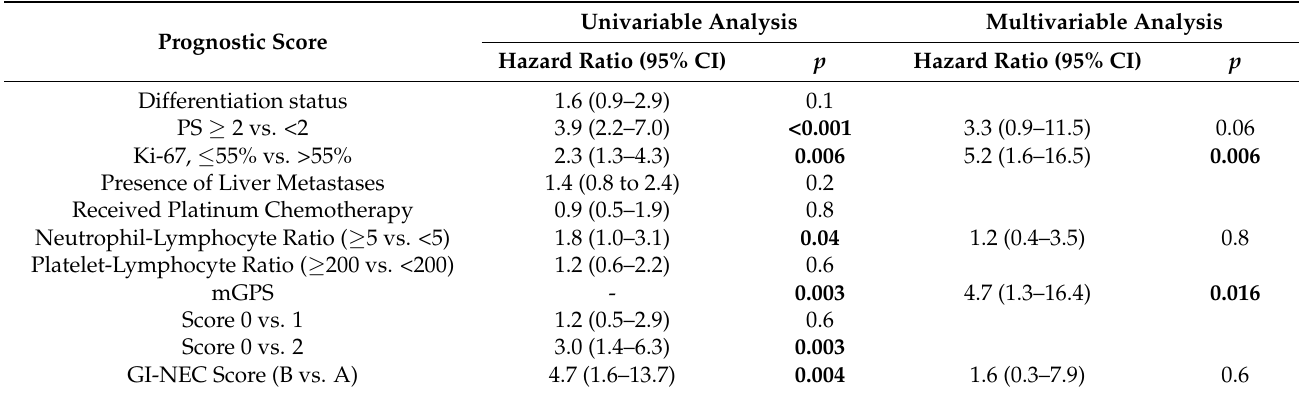
Table 3. Univariable and multivariable analysis for overall survival (entire